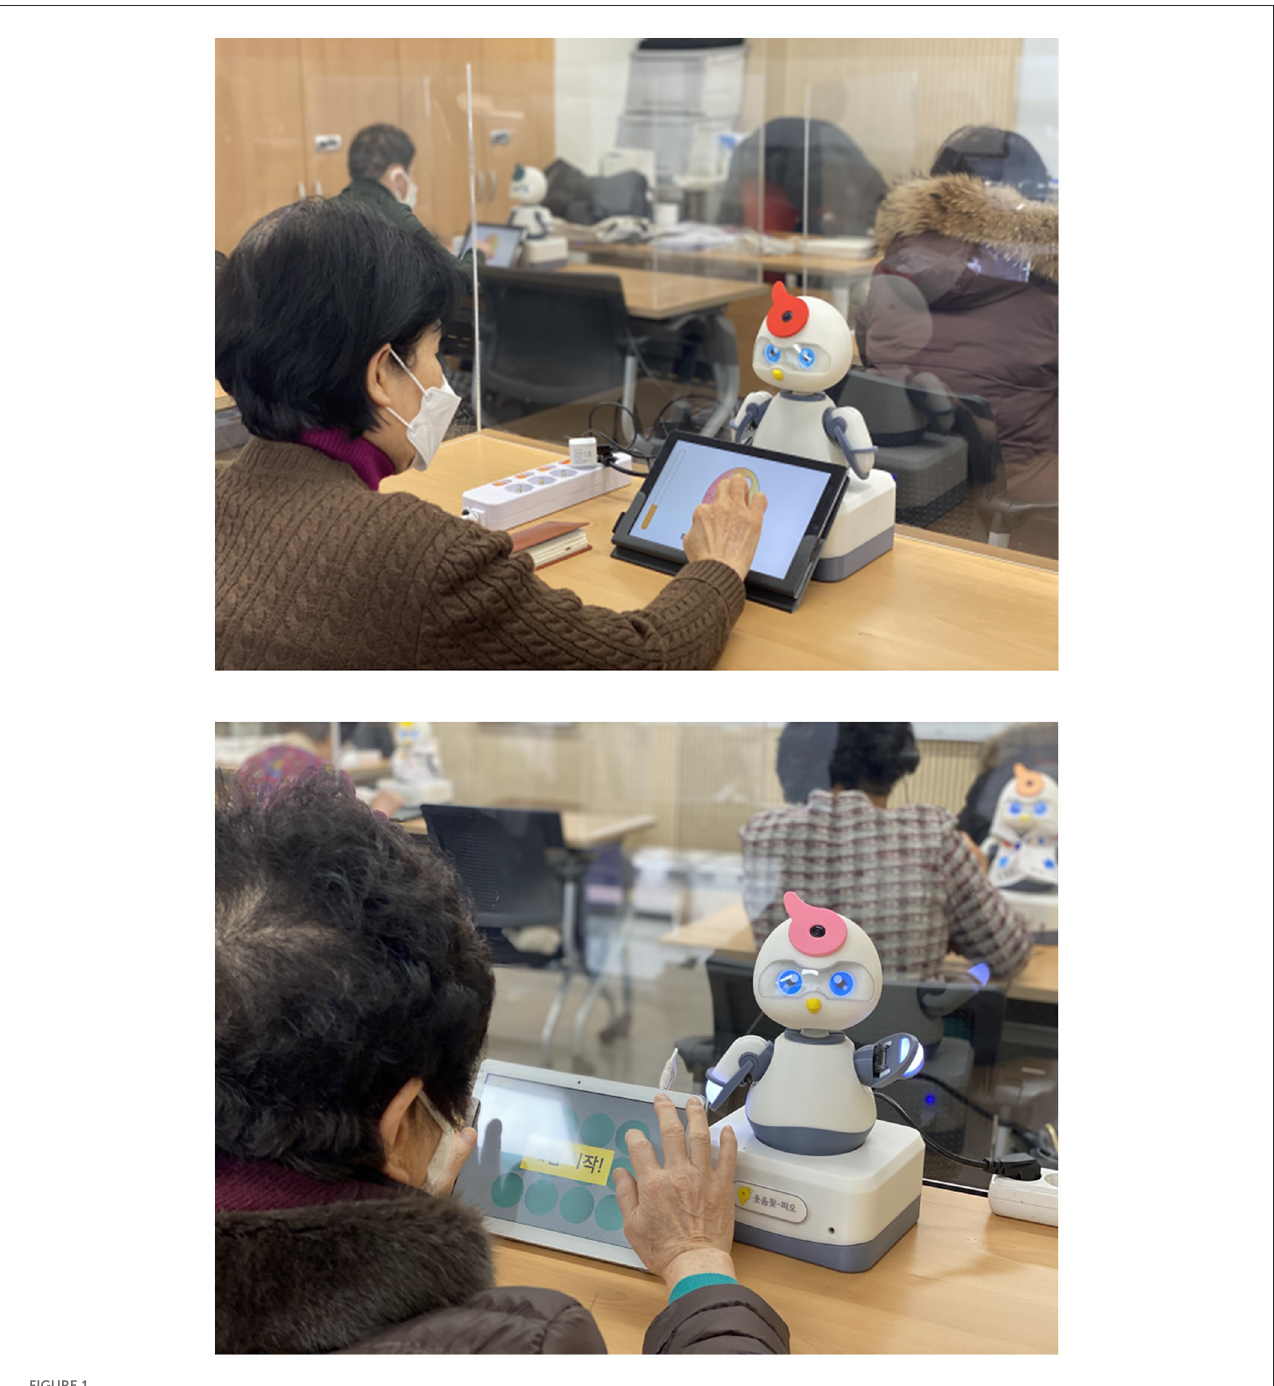
FIGURE1 Participants conducting PIO